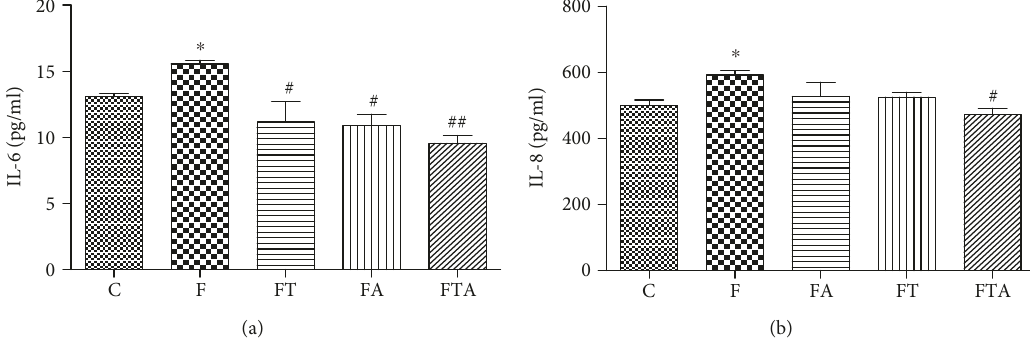
Figure 4: E ff ects of fructose intake, arginine supplementation, and aerobic exercise on IL-6, and IL-8 production in serum. C group: control group; F group: fructose group; FA group: fructose+ arginine group; FT group: fructose+training group; FTA group: fructose +training +arginine group. Data are presented as means ± SEM . Statistical analysis (one-way ANOVA and post hoc Bonferroni multiple comparison test): ∗ P < 0 05 v. the C group # P < 0 05 and ## P < 0 01 v. the F